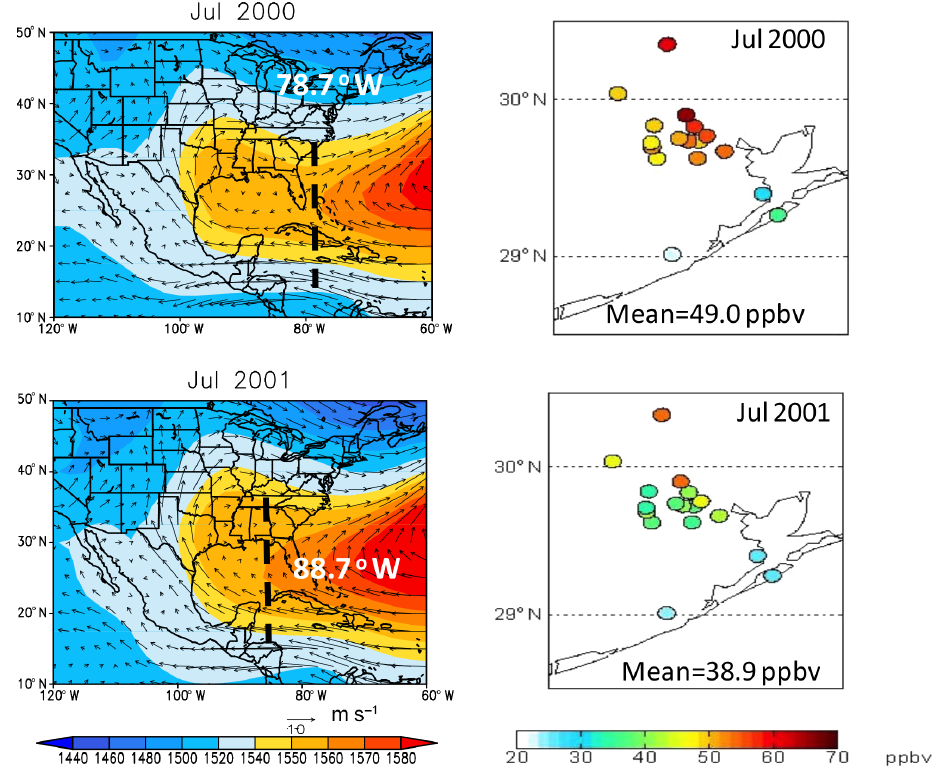
Figure 8. (Left) 850hPa geopotential height (gpm) and wind field (ms − 1 ) for the months July 2000 and July 2001. The black dashed line shows the longitude of the BH-Lon (values shown in white). (Right) MDA8 ozone concentrations at the CAMS sites in HGB for July 2000 and July 2001.